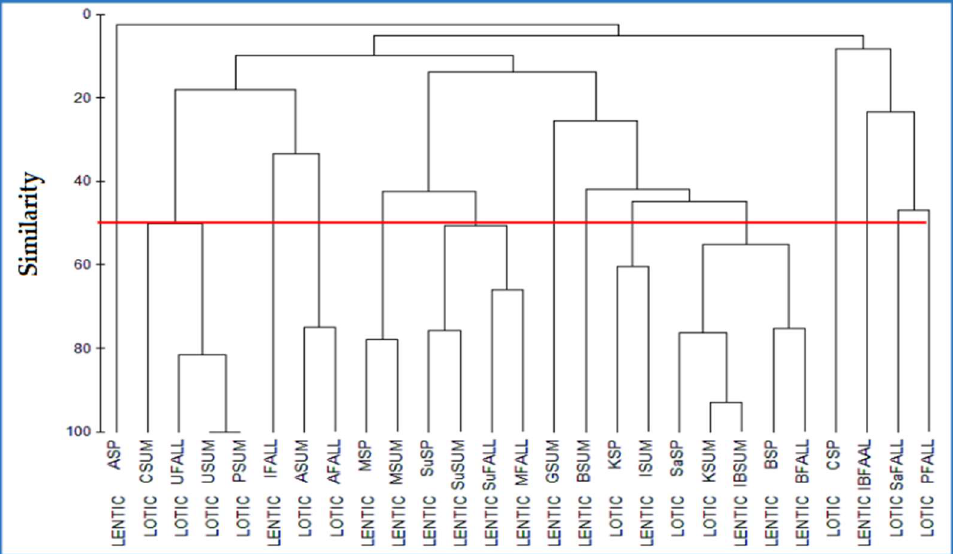
Figure 3. Cluster analysis of similarities in both lotic and lentic sites (lotic sites-A: Aksaray; C: Çeltik;